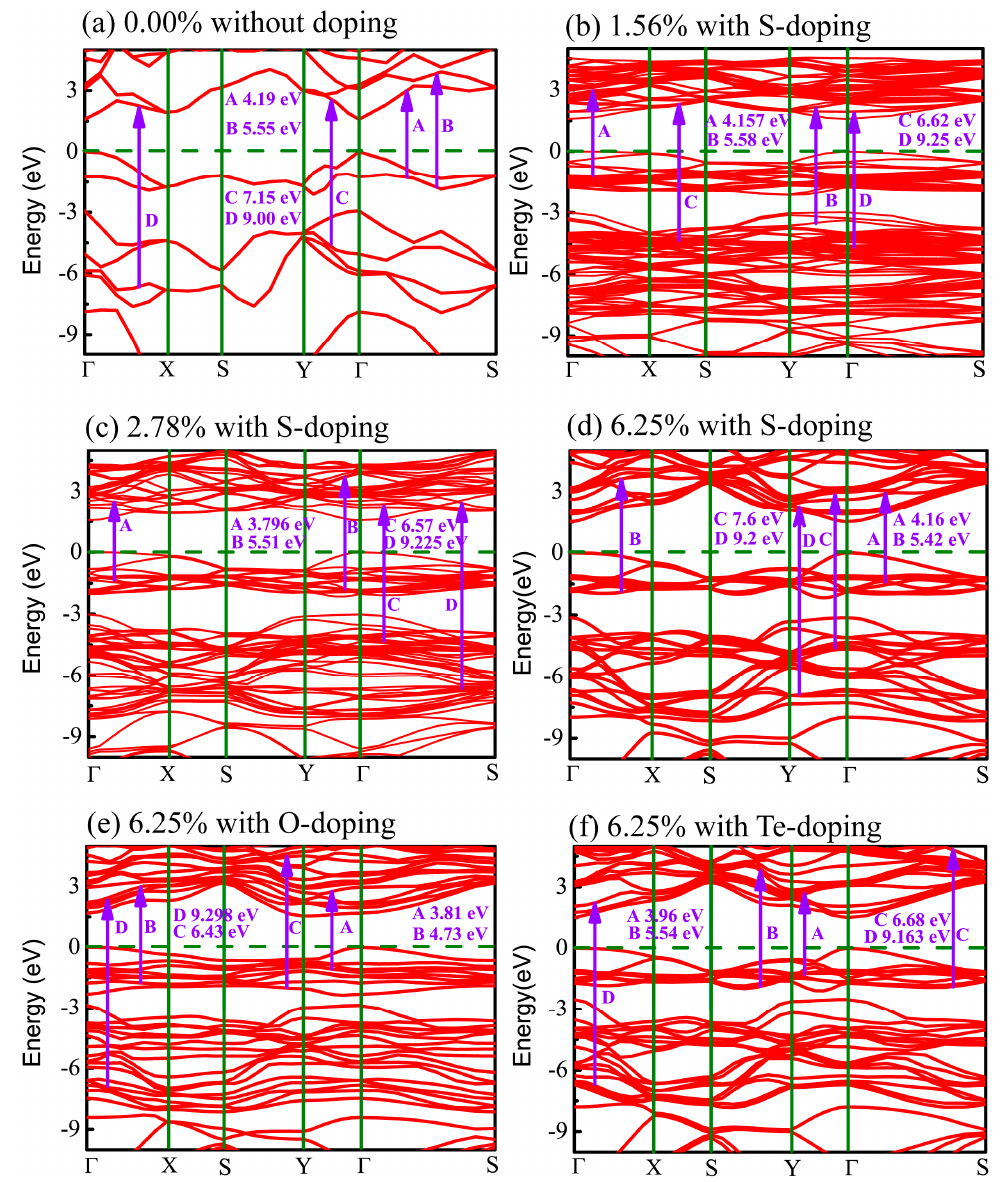
Figure 5. Band structure of monolayer CSe: ( a ) pristine monolayer; ( b – d ) S-doping at concentrations of 1.56%, 2.78%, and 6.25%, respectively; ( e ) O-doping at 6.25%; ( f ) Te-doping at 6.25%. Dashed lines specify Fermi level. Possible optical interband transitions are shown by guiding arrows. Table 2. Band gaps of monolayer CSe with and without doping.